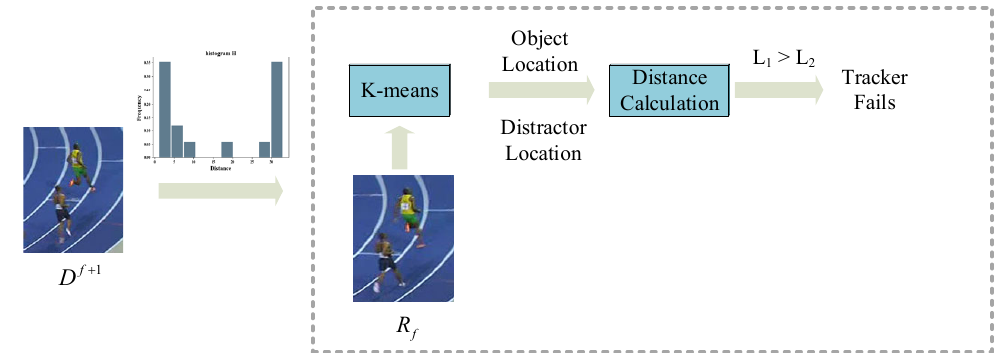
Figure 6. Transfer arbiter framework.